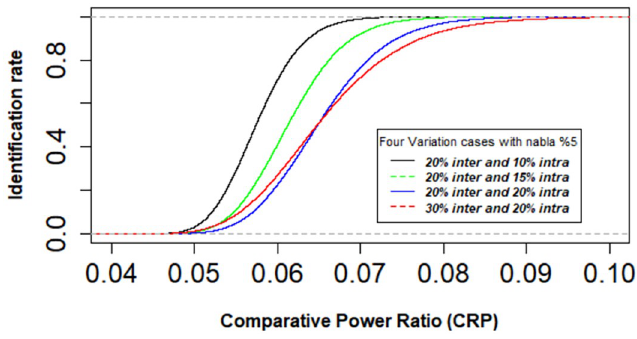
Fig 9. Cumulative distribution function of 60,000 sample for identification of faulty